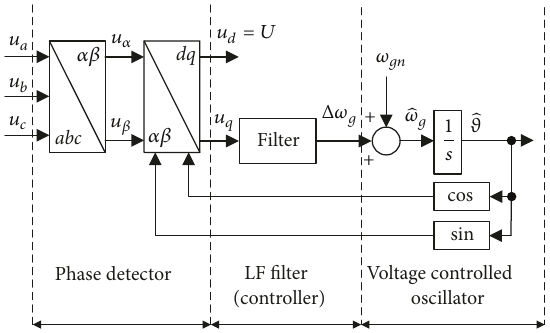
Figure 1: Block diagram of the conventional